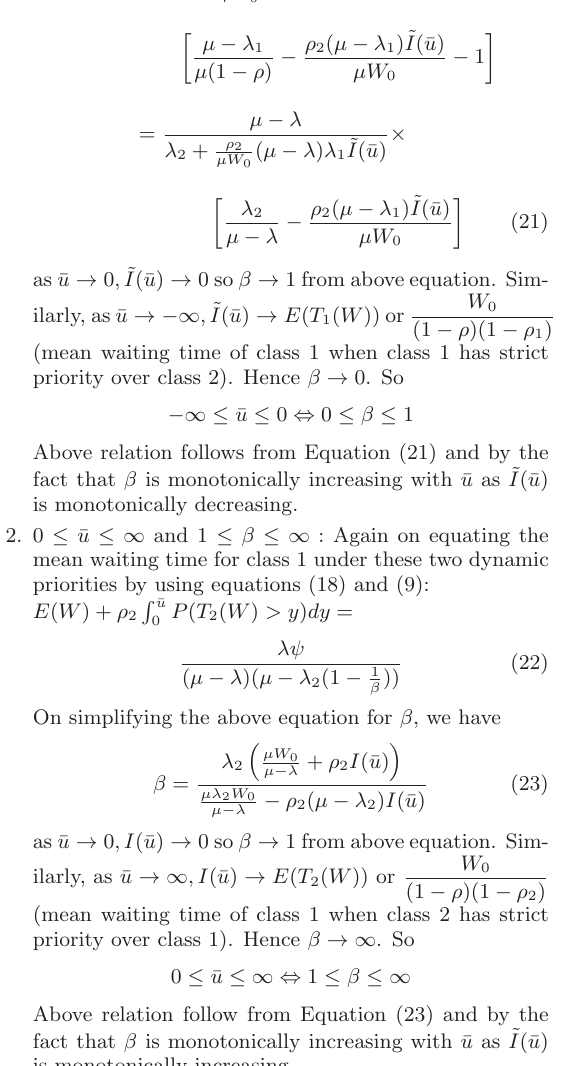
Figure 1. Consider the notation W α,i for class i as W α,i